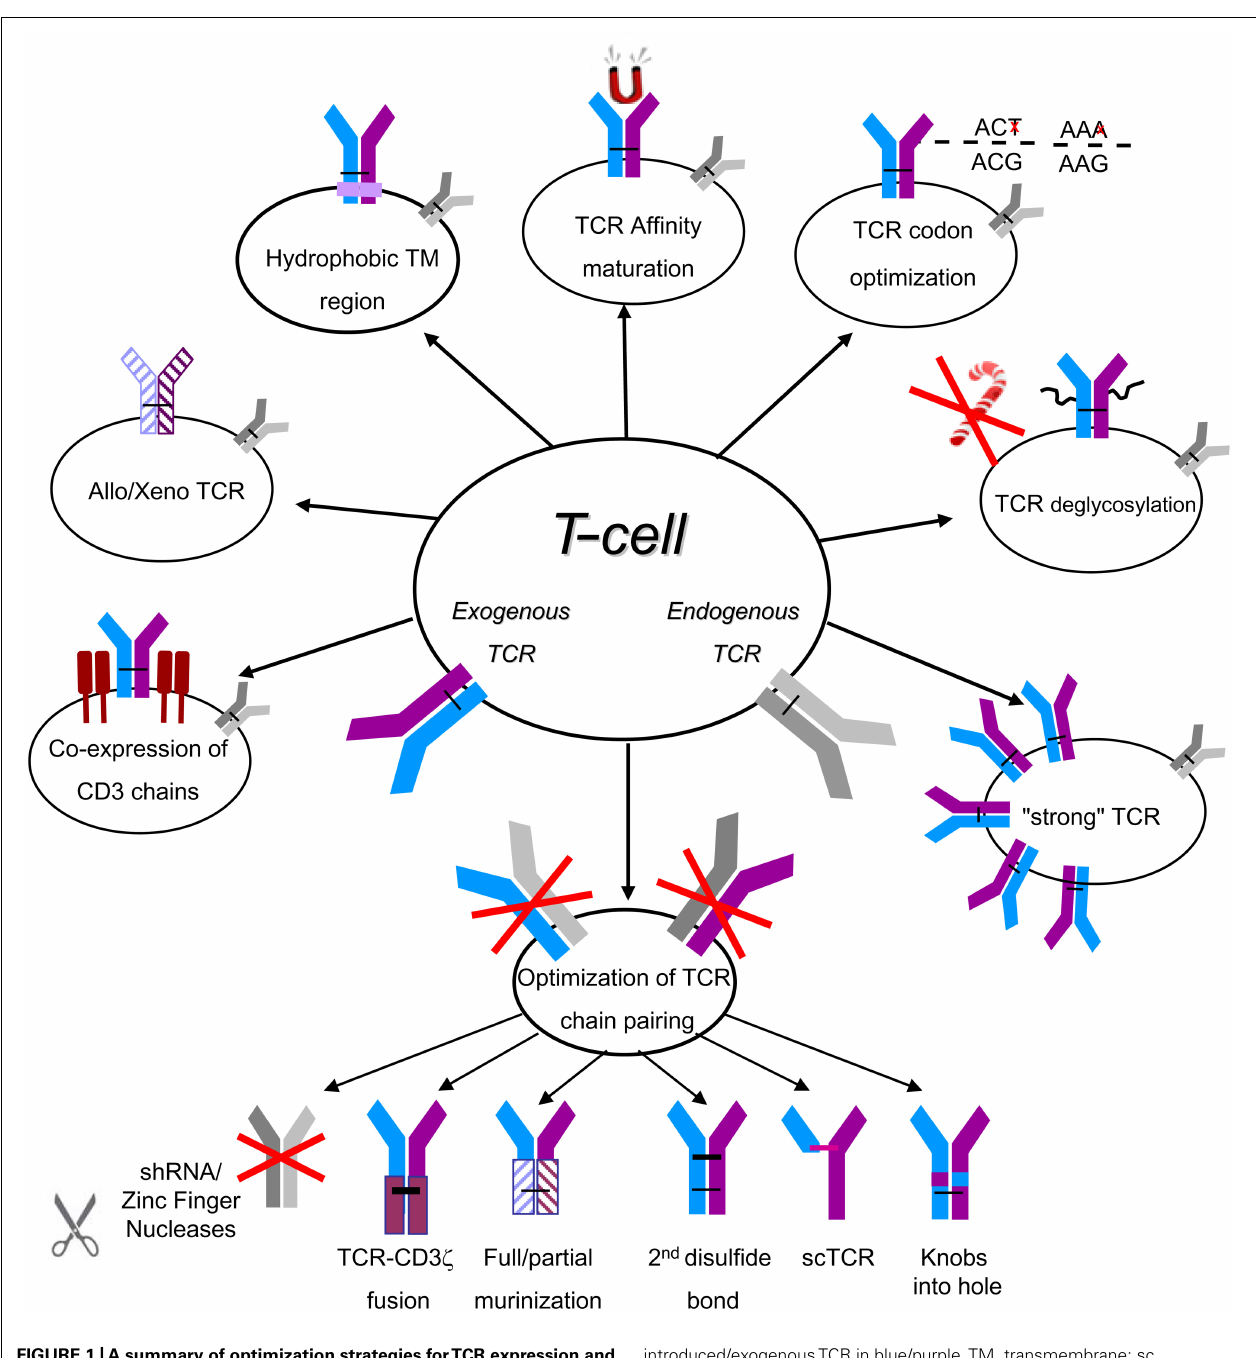
FIGURE 1 |A summary of optimization strategies forTCR expression and pairing. The naturally expressed/endogenousTCR is depicted in gray and the